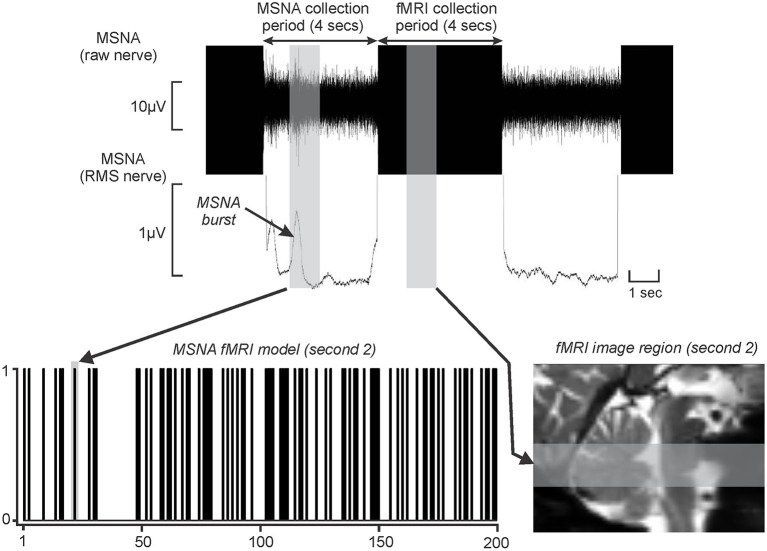
Upper panel shows a typical microneurographic recording in an individual subject during concurrent functional magnetic resonance imaging (fMRI). Brainstem images were collected during a 4 s at which time muscle sympathetic nerve activity (MSNA) activity was not distinguishable. However, due to the fMRI haemodynamic delay (~5 s) and the delay for MSNA traffic to travel from the brain to the recording electrode (~1 s), brain activity during the MSNA collection period was reflected in signal intensity changes during the subsequent 4 s period. The vertical gray shading represents a 1 s period of MSNA recording and the associated 1 s period of fMRI image collection. During each 1 s epoch of the collection period (4 s), if a MSNA burst occurred, a “1” was entered into an fMRI search model (lower left panel). This was repeated for each of the 200 fMRI volumes to create a 200 point fMRI model. The MSNA burst in the above recording is entered into the fMRI search model (vertical gray bar). The MSNA burst that occurred during the 2nd second of the collection period arose during collection of fMRI images through the rostral medulla and pons. This brainstem region is represented by the gray horizontal shading on a sagittal section of an individual's fMRI images set (lower right panel). RMS: root mean square. This figure is modified from our previous publication (Fatouleh et al., 2015).